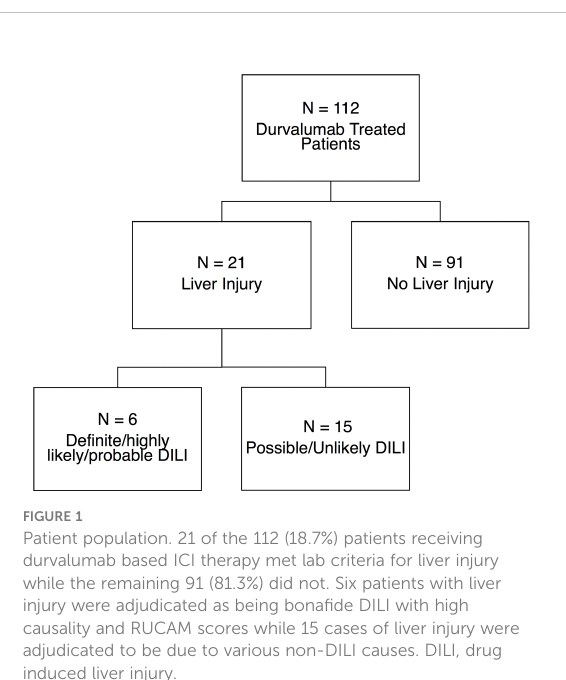
FIGURE 1 Patient population. 21 of the 112 (18.7%) patients receiving durvalumab based ICI therapy met lab criteria for liver injury while the remaining 91 (81.3%) did not. Six patients with liver injury were adjudicated as being bona fi de DILI with high causality and RUCAM scores while 15 cases of liver injury were adjudicated to be due to various non-DILI causes. DILI, drug induced liver